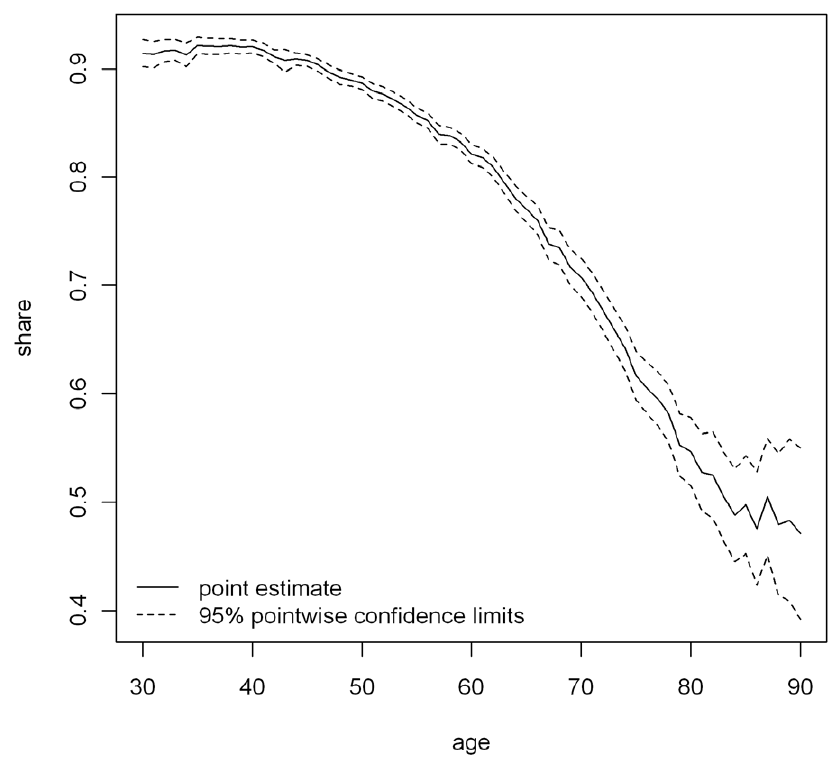
Figure 3. The share of breast cancer attributable health expenditures.